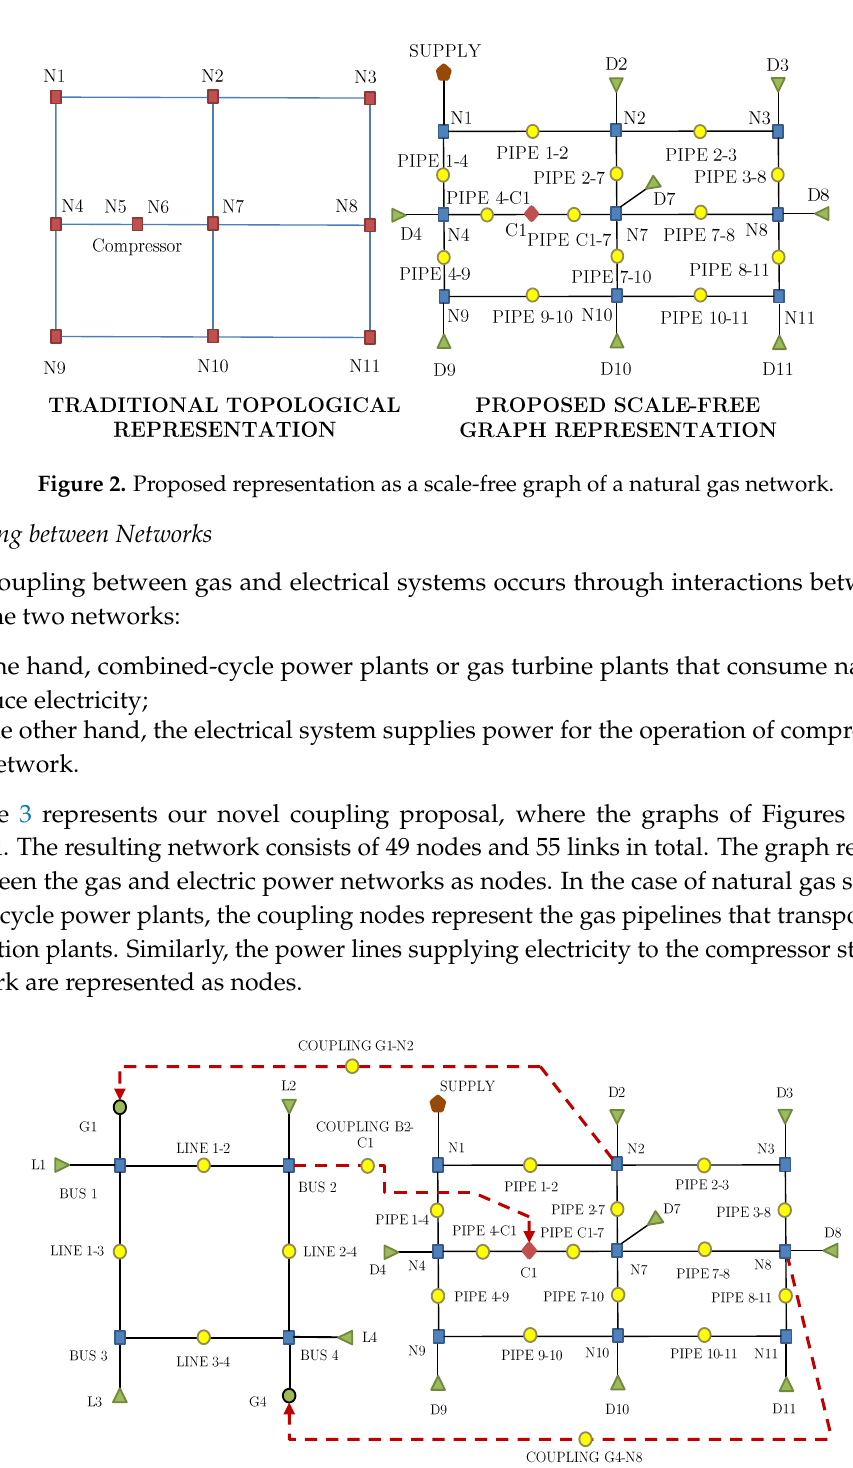
Figure 3. Scale-free graph of coupled electric power and gas